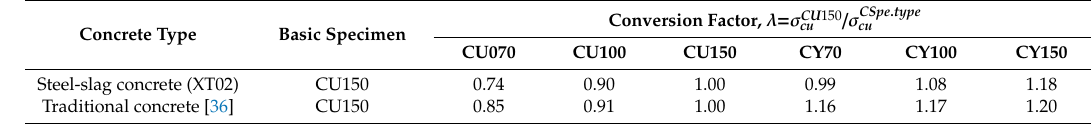
Table 8. Conversion factors in compressive strength using various specimen